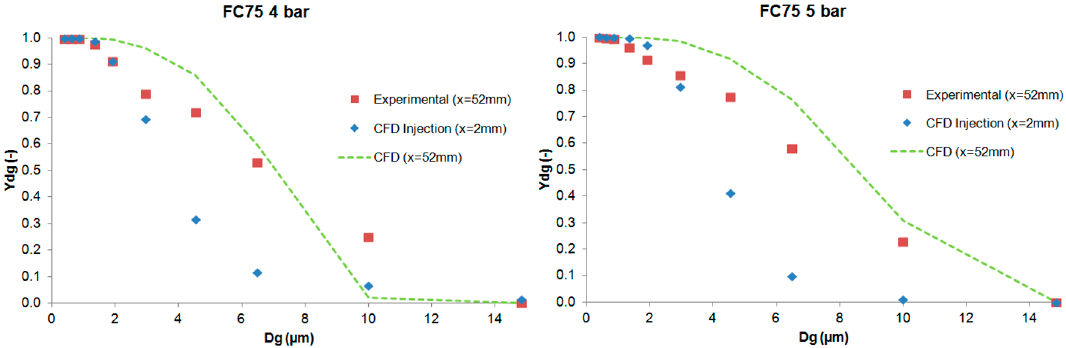
Figure 13. Experimental and numerical cumulative mass distribution based on droplet size for the FC75 compound.